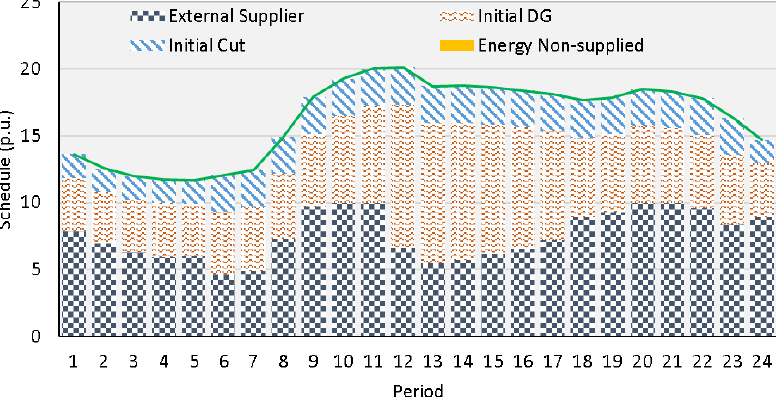
Figure 5. Scheduling before aggregation and remuneration processes.